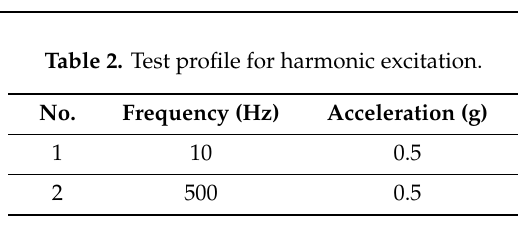
Table 3. Temperature conditions in the uniaxial excitation test.